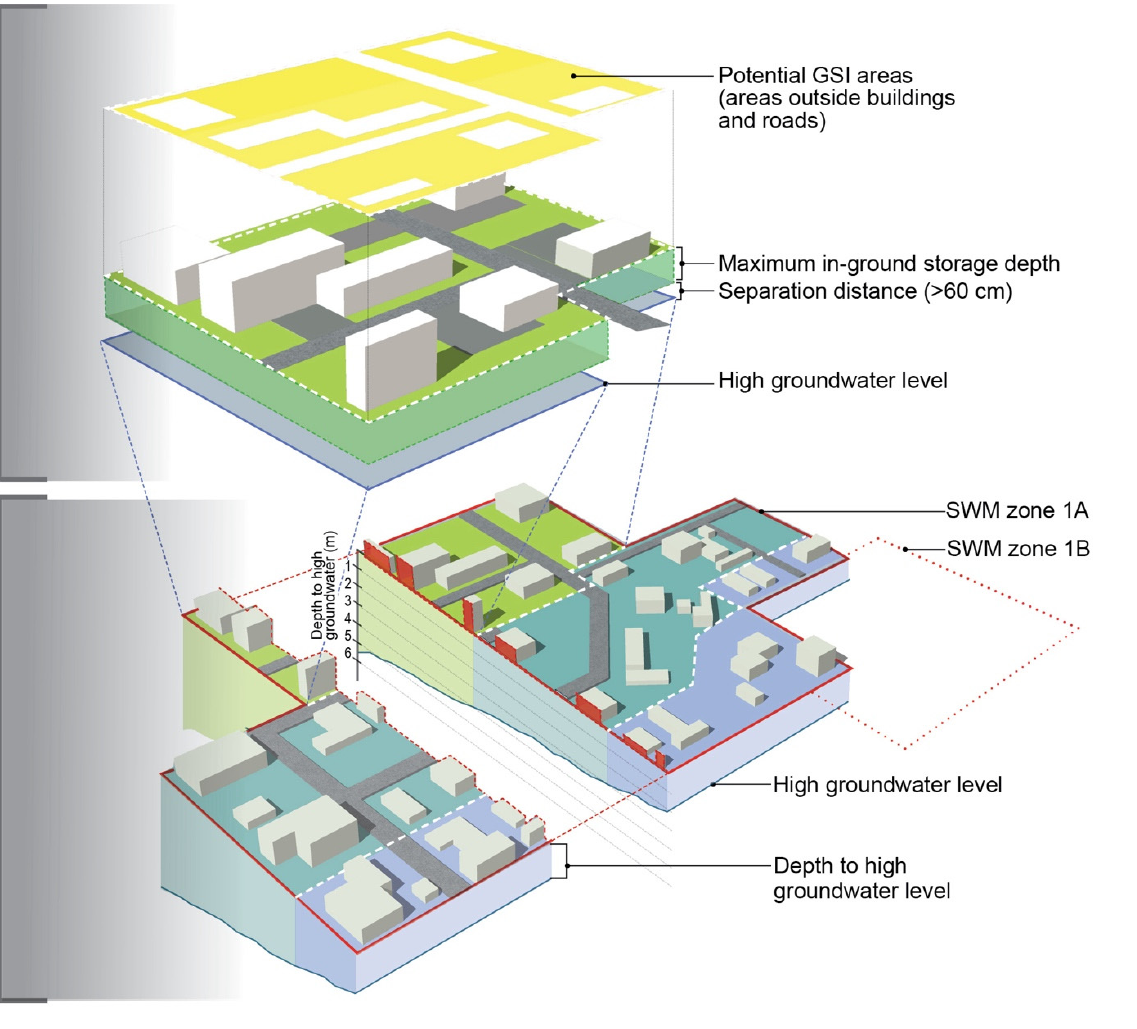
Figure 4. Three different GW areas within Zone 1A (divided by dotted white lines) are differentiated by different ranges of depths to high groundwater. Maximum in-ground storage depth and potential GSI areas (yellow shade) of each GW area are quantified to estimate storage capacity.